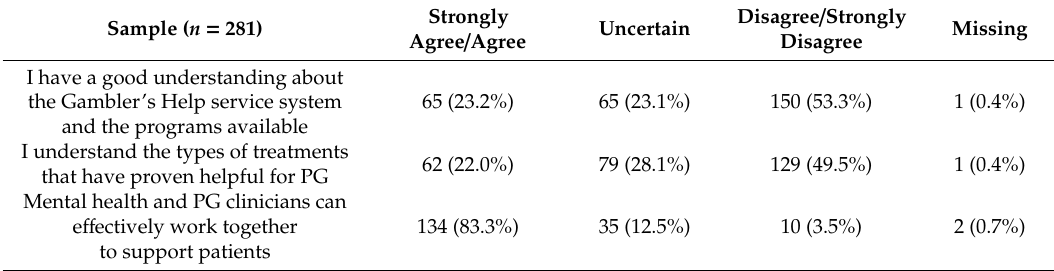
Table 4. Current treatment practices and knowledge about treatment